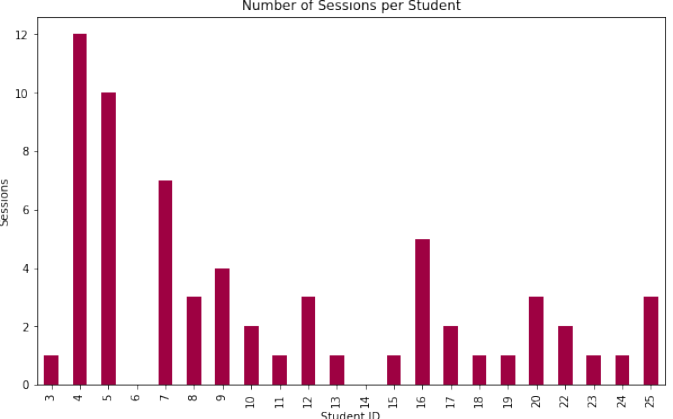
Figure 4. Number of Sessions per Student.